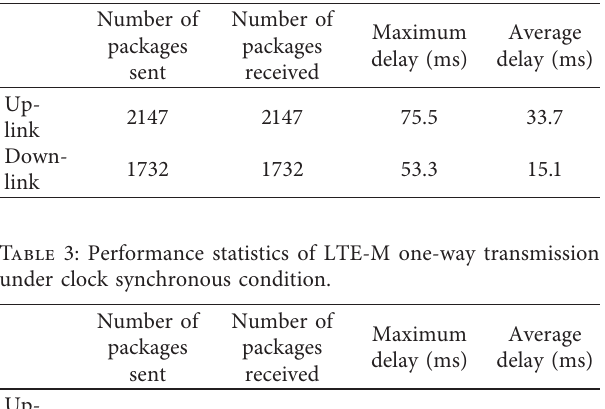
Table 2: Performance statistics of LTE-M one-way transmission under clock asynchronous condition.